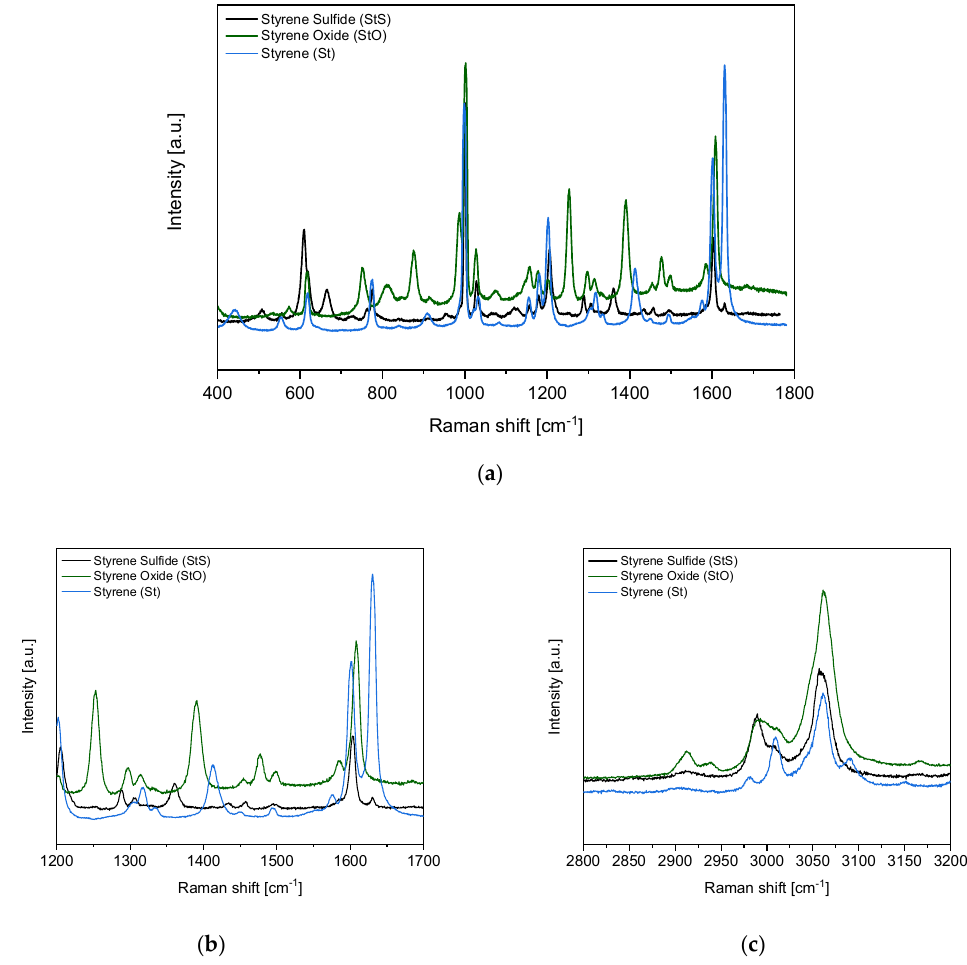
Figure 2. Raman spectrum of styrene oxide (StO)—substrate, and styrene sulfide (StS)—product (monomer), ( a ) in the middle Raman shift region; ( b ) in the Raman shift region of significant changes; ( c ) in the high Raman shift region. The Raman spectrum of styrene (St) was added for comparison.